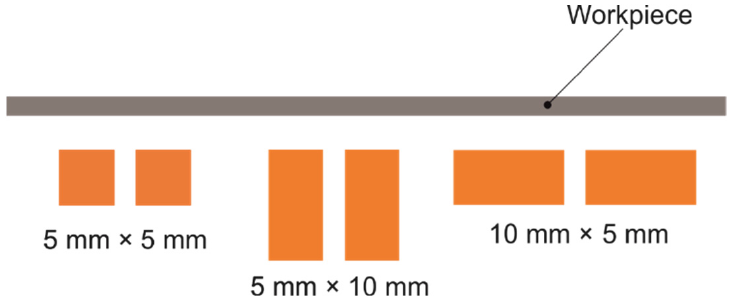
Figure 8. Three different coil cross-sections studied for the experiments.